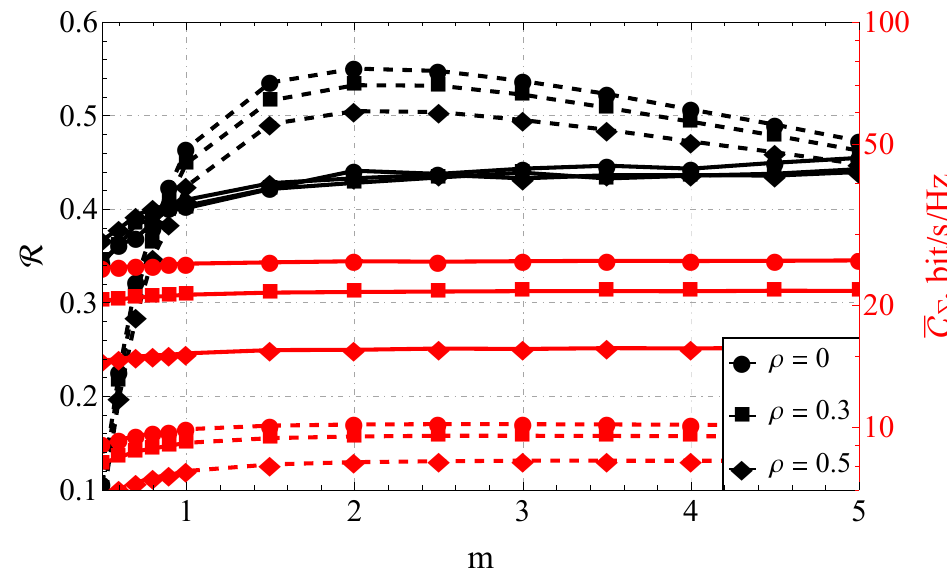
Figure 5. The joint R – C Σ performance of the 8 × 8 and 2 × 2 MIMO systems for various m ’s, γ = 20 dB, and different ρ